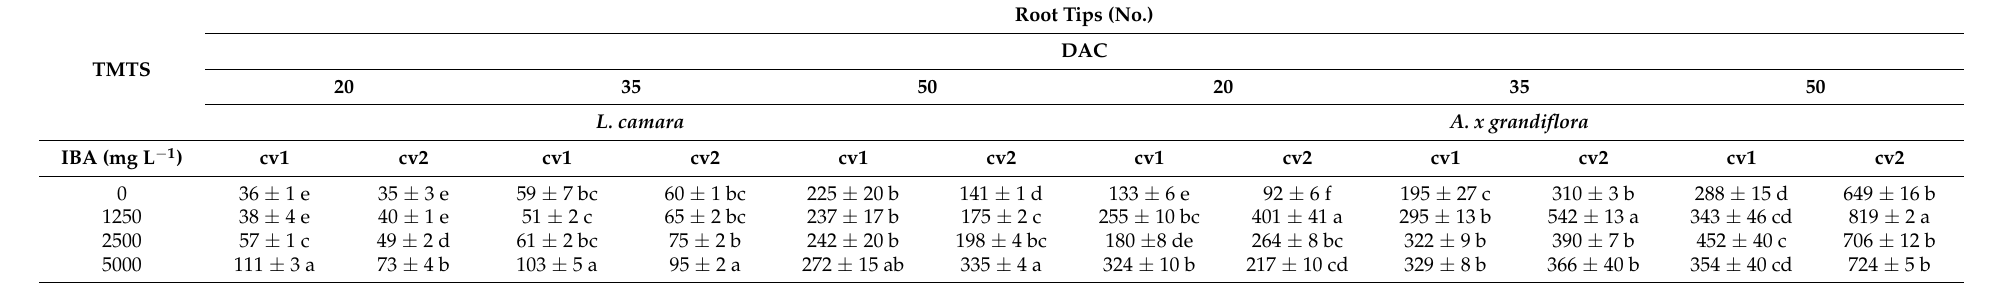
Table 3. Number of root tips per cutting in wild sage and glossy abelia at 20, 35 and 50 DAC, according to IBA concentration and cultivar.